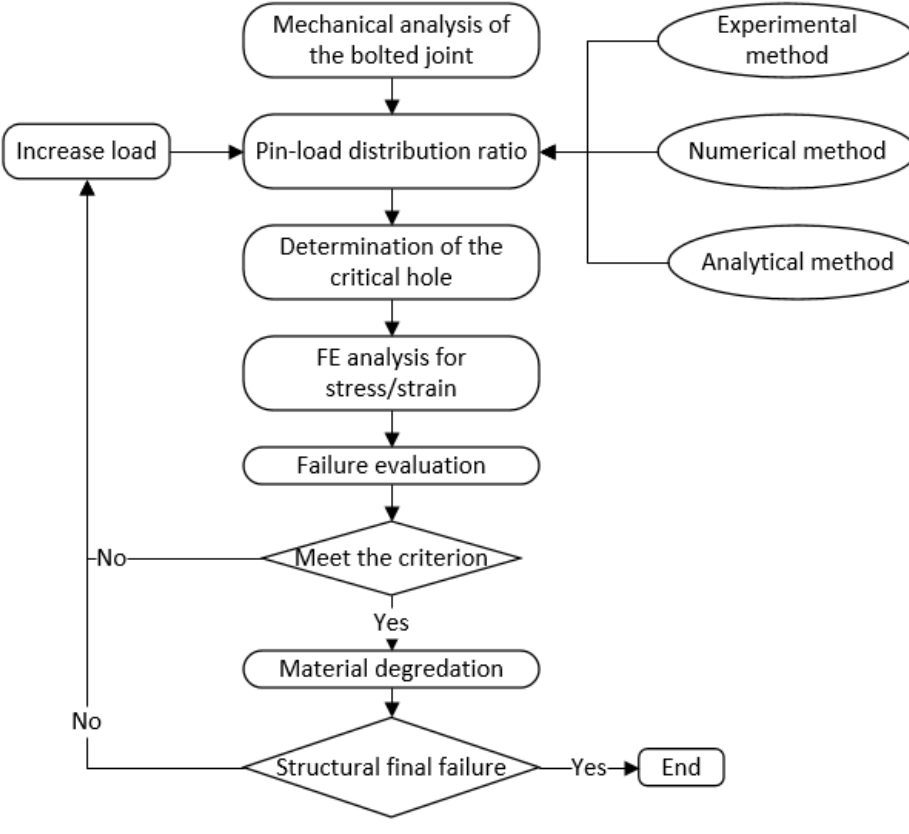
Figure 2. Flowchart for the failure analysis of the bolted joints.